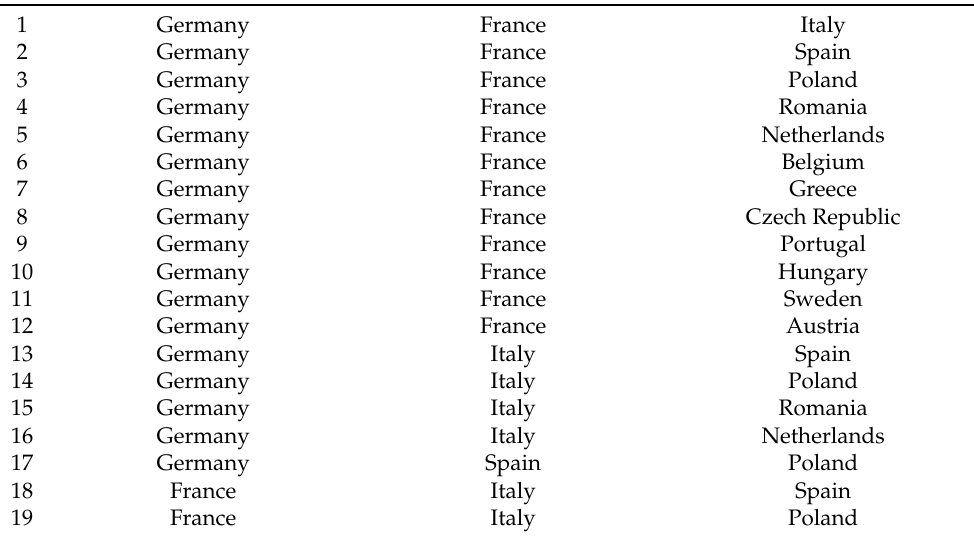
Table A6. Coalitions that reach the population quota but cannot reject a decision in the 27-member EU after Brexit.